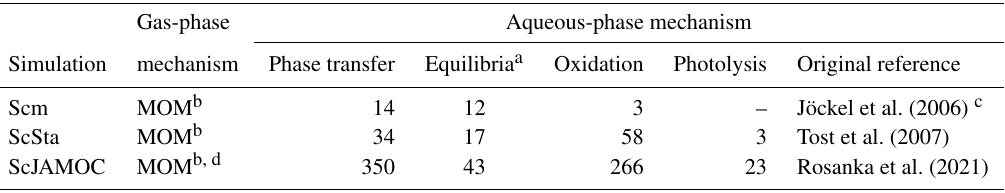
Table 1. Characteristics of the gas- and aqueous-phase mechanism used for each simulation performed in this study using CAABA and EMAC.